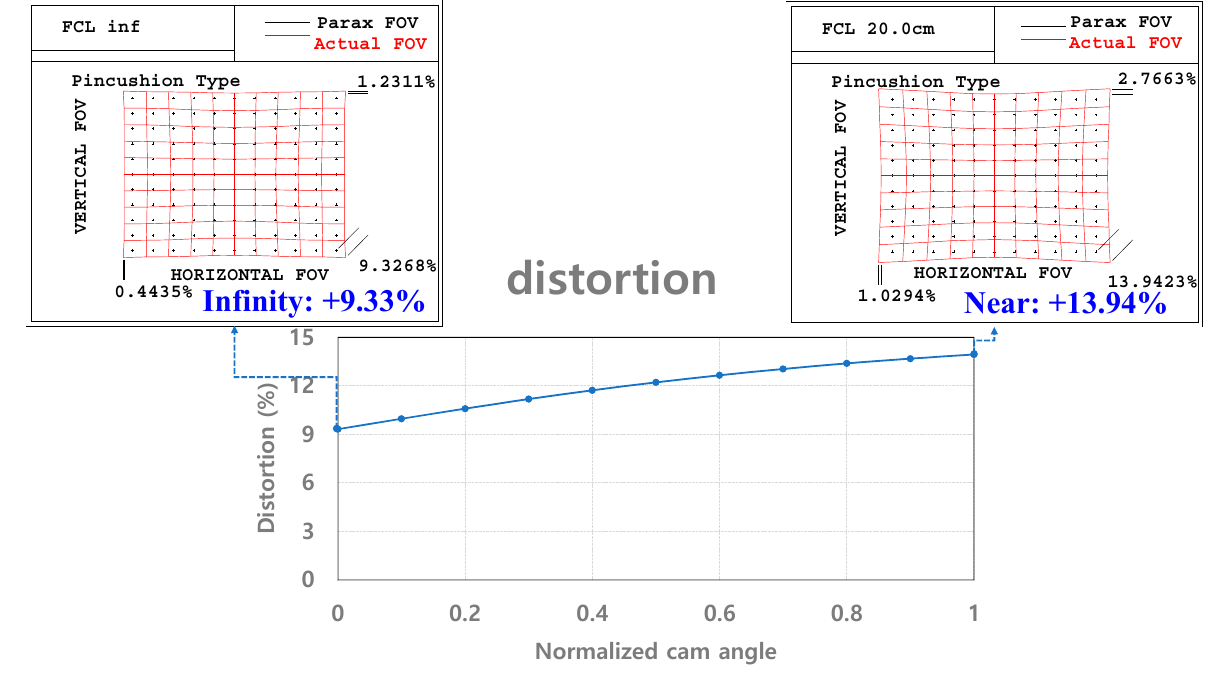
Figure 4. Distortion graphs for the final collimator design. In the optical design stage, the focal length of the test lens was 4 mm, and the image height was assumed to be 5.8 mm. Because the optical system distortion changes, the entire optical system magnification changes from − 0.0293 to − 0.0308. Therefore, although the target size must be changed according to the inspection distance, the target size must be fixed [49]. Depending on the magnification and distortion of the optical system, the target size can be calculated using Equation (5) [50,51]. As shown in Figure 3, the distortion D can be calculated as Equation (5), y p is the height calculated by finite ray tracing, and y 0 is the height by paraxial ray